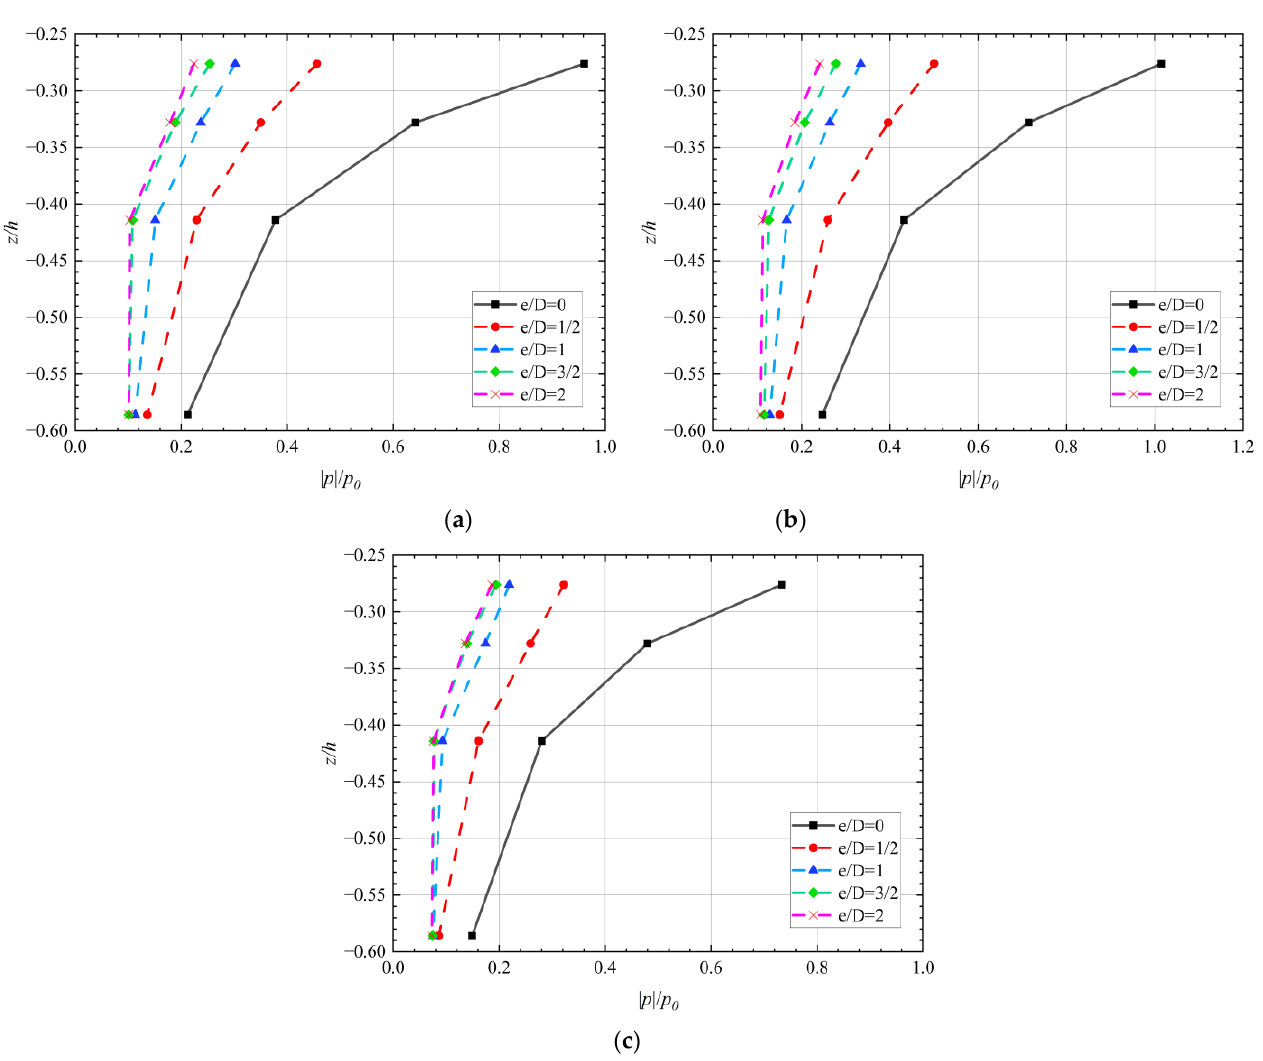
Figure 7. Variation of the dimensionless pore pressure amplitude beneath the pipeline under differ- ent backfill depths when 𝑈 𝑐 = 0 m/s and ± 0.3 m/s. ( a ) 𝑈 𝑐 = 0 m/s; ( b ) 𝑈 𝑐 = 0.3 m/s; ( c ) 𝑈 𝑐 = − 0.3 backfill depths when U c = 0 m/s and ± 0.3 m/s. ( a ) U c = 0 m/s; ( b ) U c = 0.3 m/s; ( c ) U c = − 0.3 m/s.